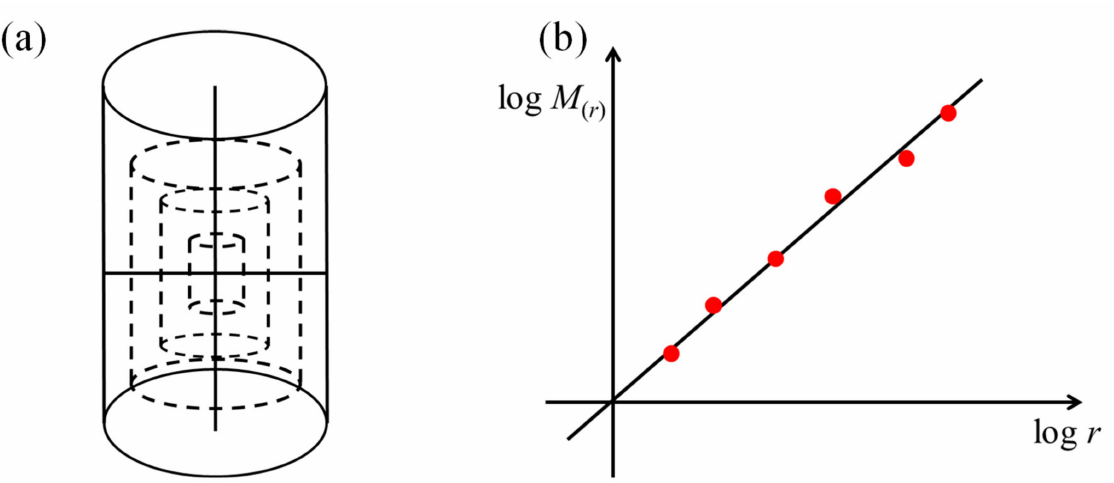
Figure 12. Schematic diagram of AE spatial fractal dimension calculation: ( a ) column-covering method, ( b ) AE spatial fractal